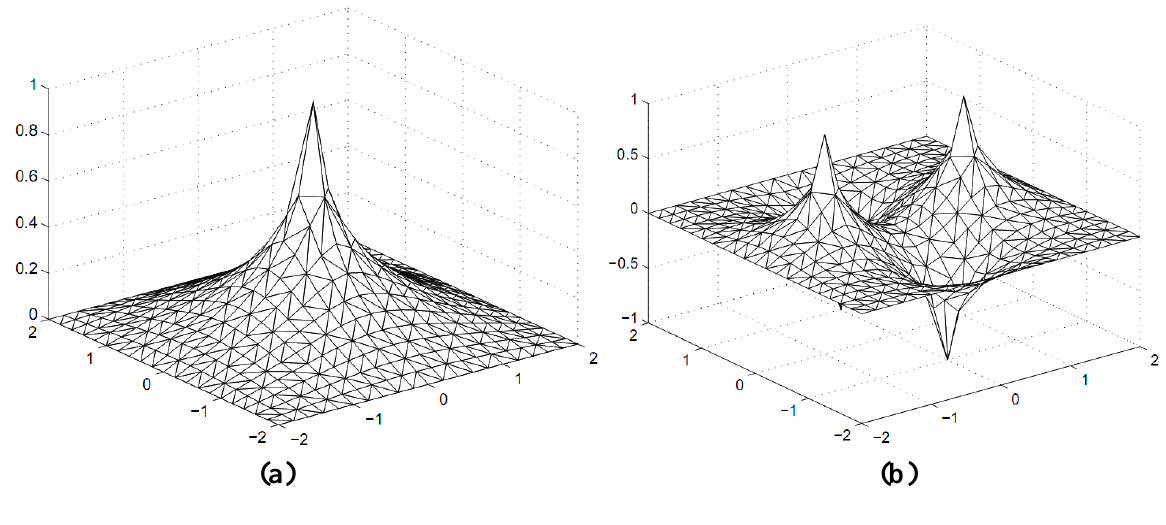
Figure 3. Results of Laplace problems in several non-convex